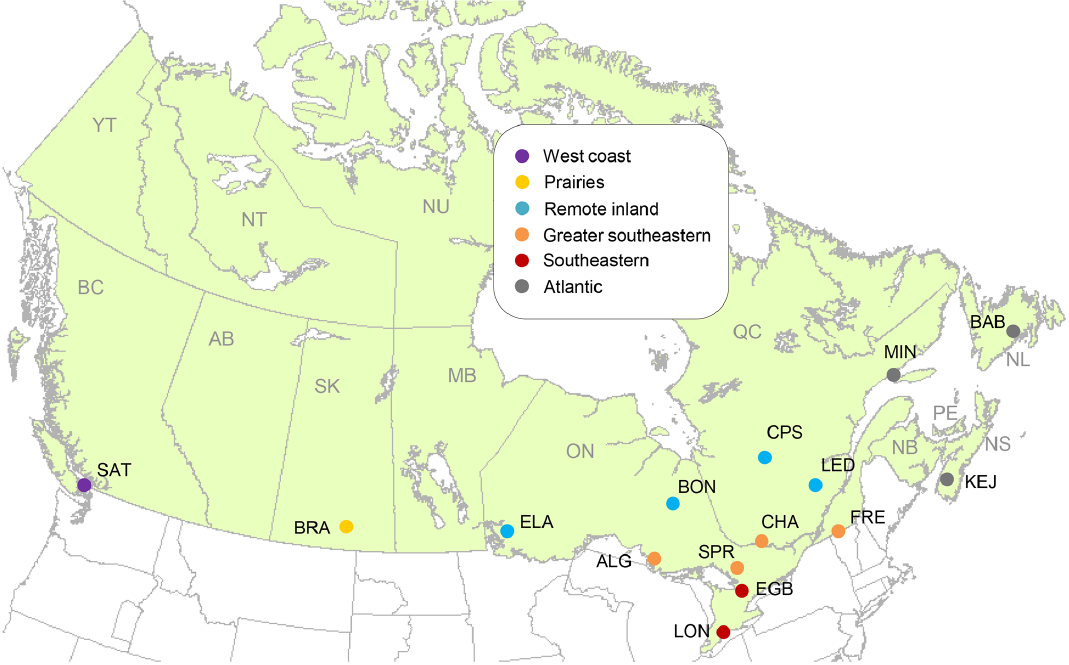
Figure 1. Map of CAPMoN sites analyzed in this study and their regional